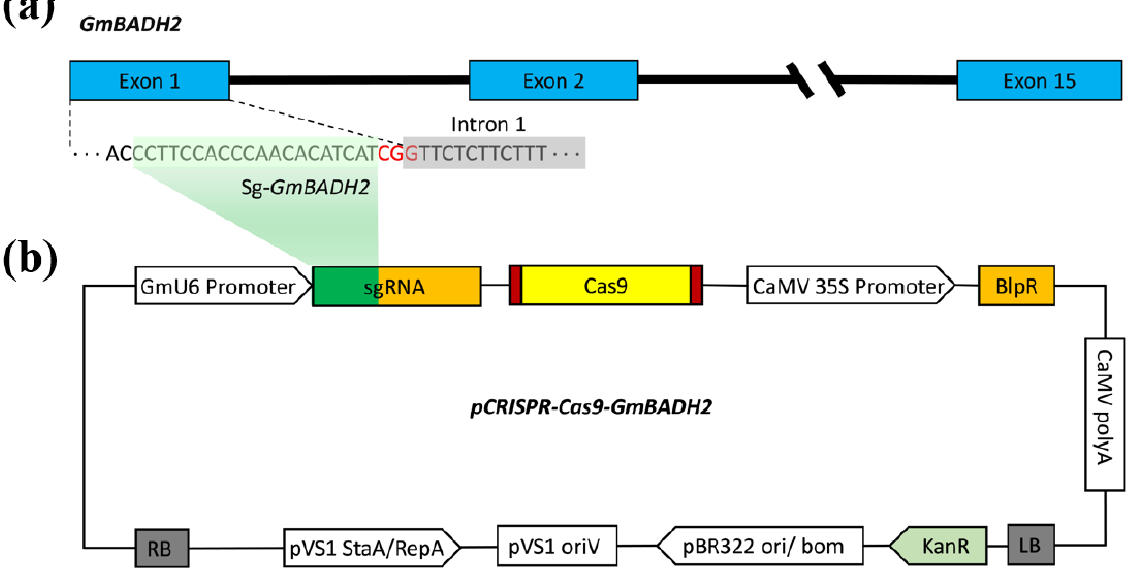
Figure 3. Targeted editing of GmBADH2 using the CRISPR/Cas9 system. ( a ) Exon–intron structure of GmBADH2 . Exons and introns are indicated by blue rectangles and a black horizontal line, respectively. The nucleotide sequence highlighted in green indicates the region targeted by the sgRNA designed in this study. The nucleotide sequence highlighted in gray indicates intron 1 and the red bases represent the PAM sequence. ( b ) Schematic diagram of the gene knockout vector pCRISPR-Cas9-GmBADH2; GmU6 indicates the soybean U6 promoter. Genes encoding Cas9 and BlpR were expressed under the control of the CaMV 35S promoter. BlpR, phosphinothricin resistance gene; LB, left border; and RB, right border.